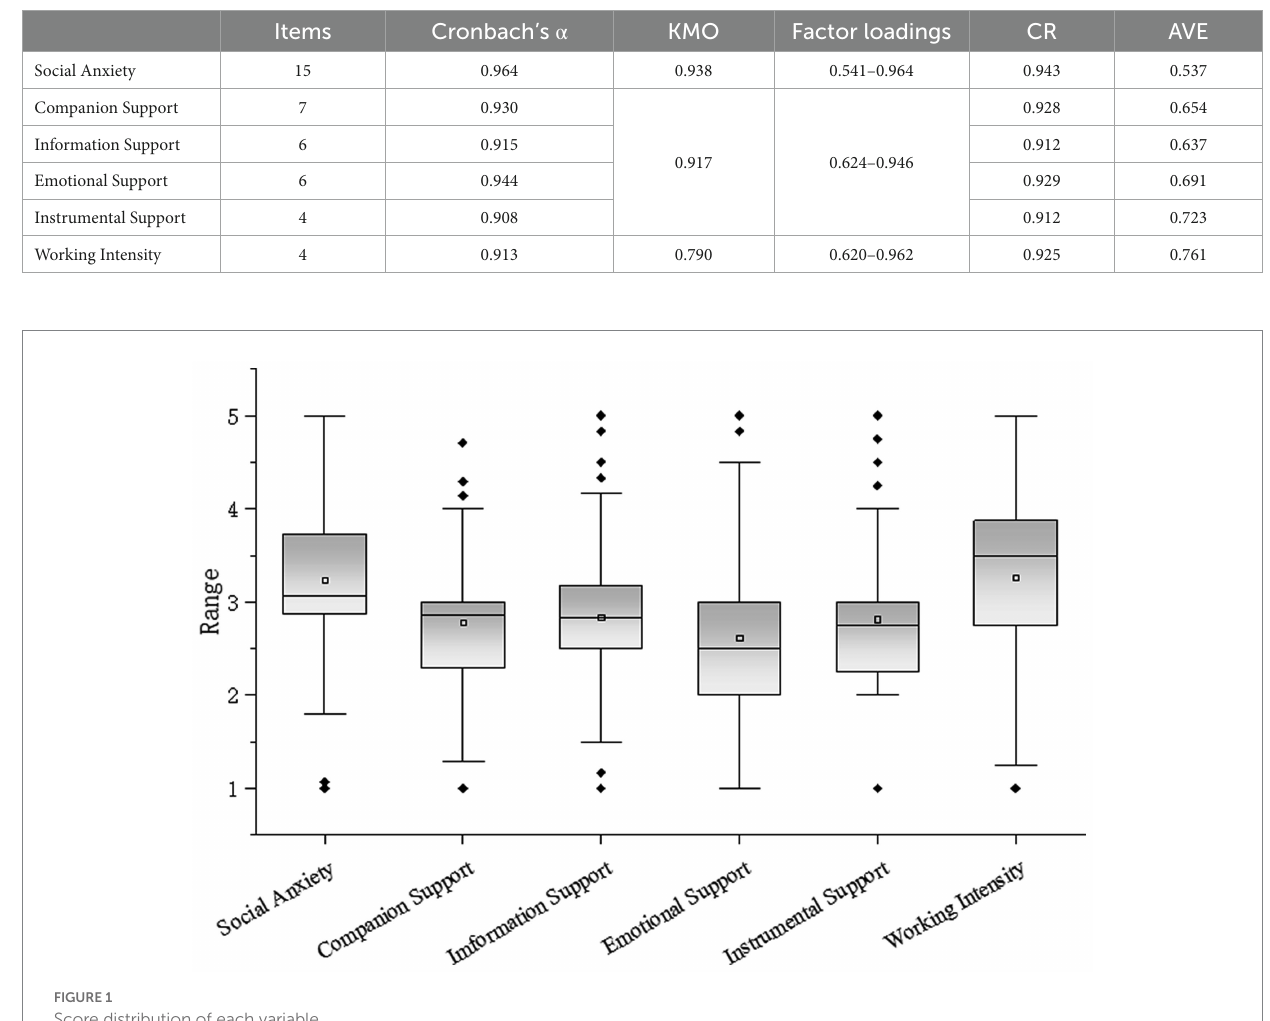
FIGURE 1 Score distribution of each